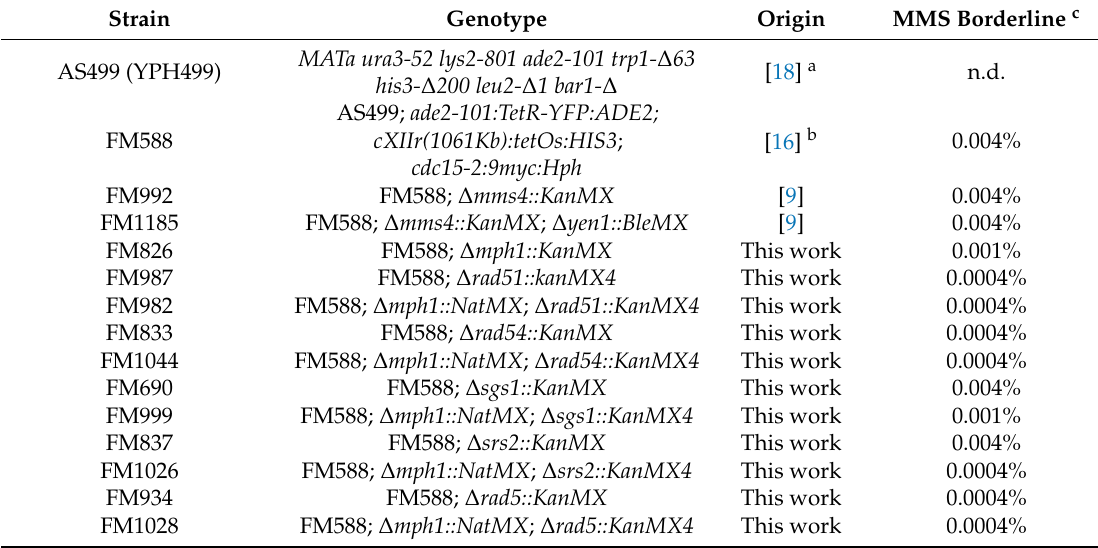
Table 1. Strains used in this study and their corresponding methyl methanesulfonate (MMS) borderline